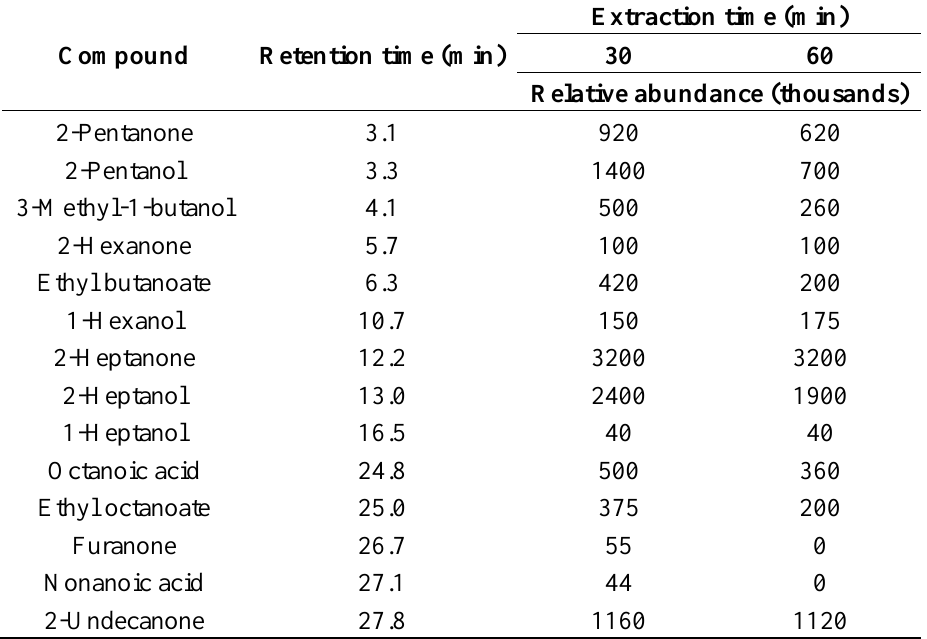
Table 4. Relative abundance of volatile compounds in Queso Fresco when extracted at 60 °C for 30 or 60 min.